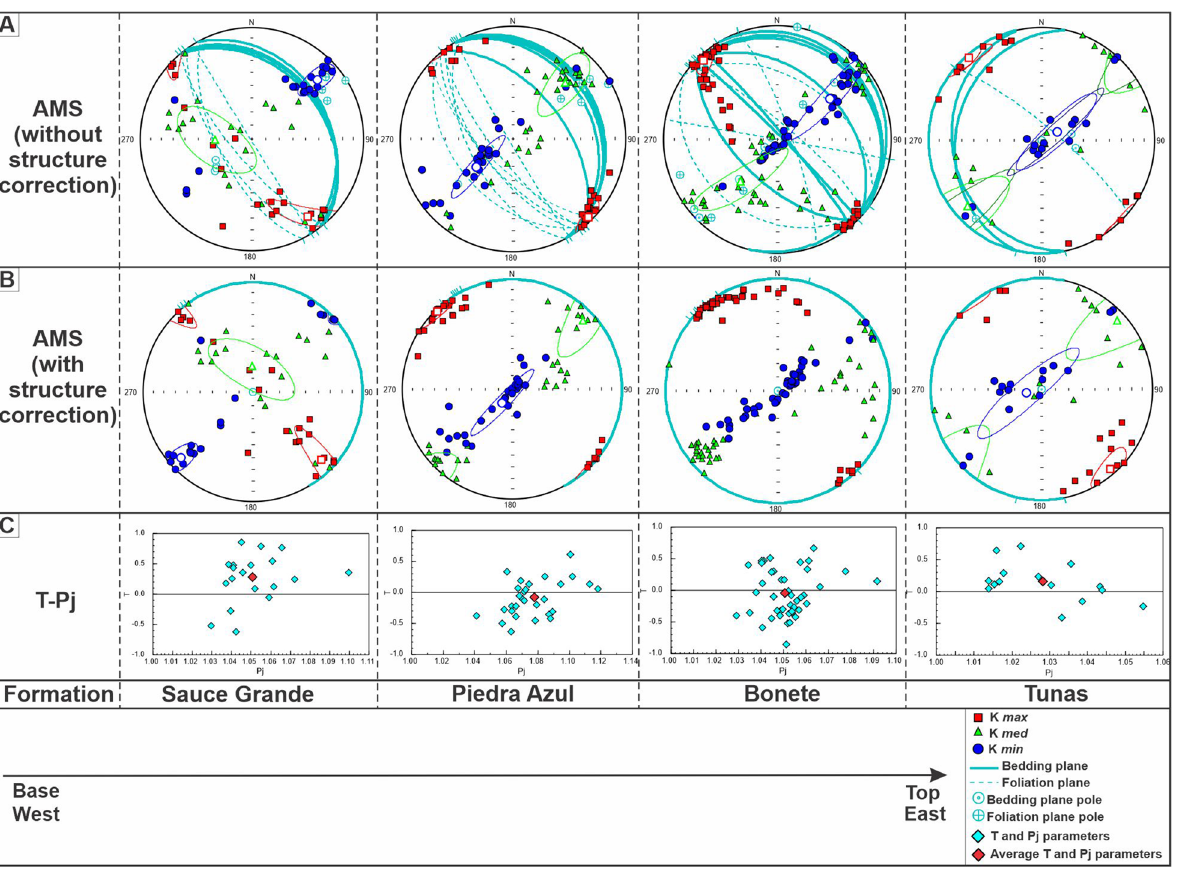
Figure 6. AMS data (Lower hemisphere Schmidt equal area projection) of the different formations of the Pillahuincó Group, on Arroyo Atravesado section (Fig. 1), from de base to the top. ( A ) AMS ellipsoids with its confidence ellipses 61 , bedding planes, foliation and the poles of both planes are showing, ( B ) AMS ellipsoids with structural correction, setting the bedding planes in the horizontal position, with its confidence ellipses 61 , ( C ) ratio between the degree of anisotropy (P j ) and the shape parameter (T), with the average values in red. Data processed with the Anisoft 5.1.08